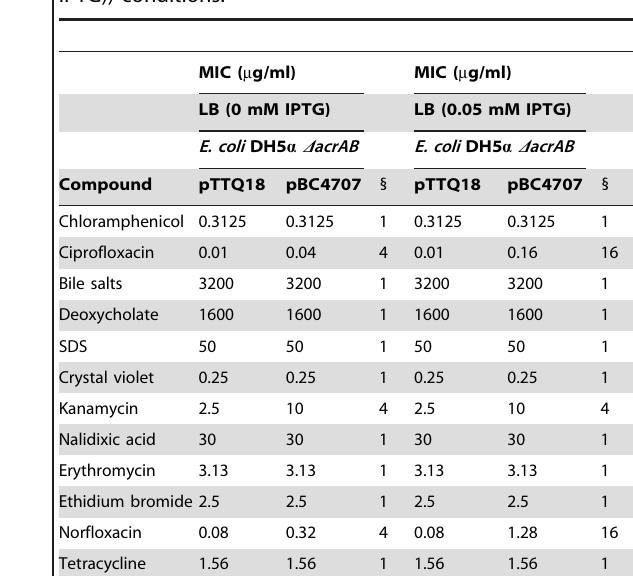
Figure 6. SRCD analysis of purified BC4707-RGSHis 6 protein. CD spectral analysis of BC4707-RGSHis 6 was performed over 260- 170 nm at 1 nm intervals with an integration time of 1 s. The spectrum shown is buffer subtracted and is an average of 10 scans. The dashed line represents the HT voltage at the photomultiplier.